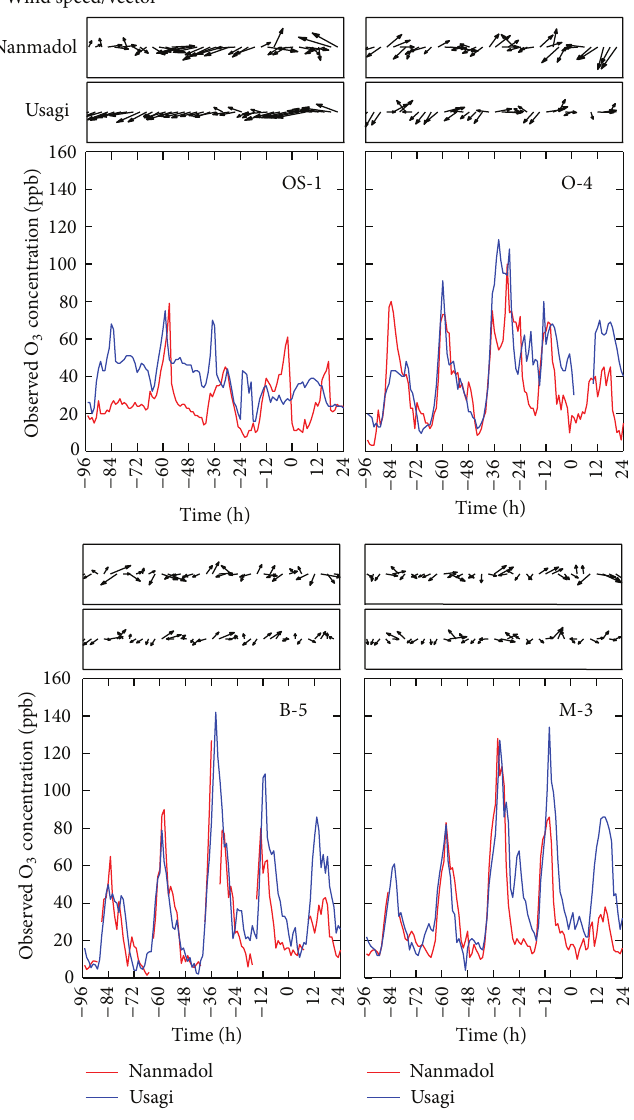
Figure 3: Observed ozone concentration in the ambient air before and after the invasion of typhoon Nanmadol (August 24 ∼ 28, 2011) and typhoon Usagi from September 16 to 20, 2013. (Time = 0 is the time for issuing sea warning for typhoons.)